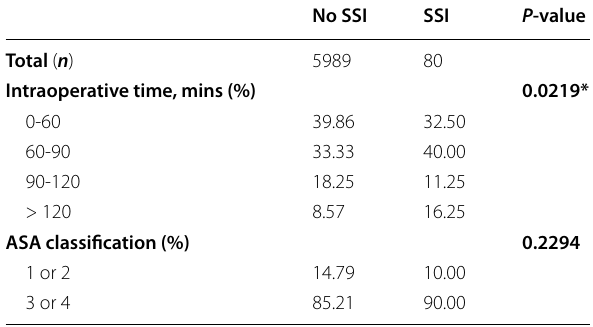
Table 3 Perioperative variables of geriatrics undergoing hip hemiarthroplasty stratified by occurrence of surgical site infection